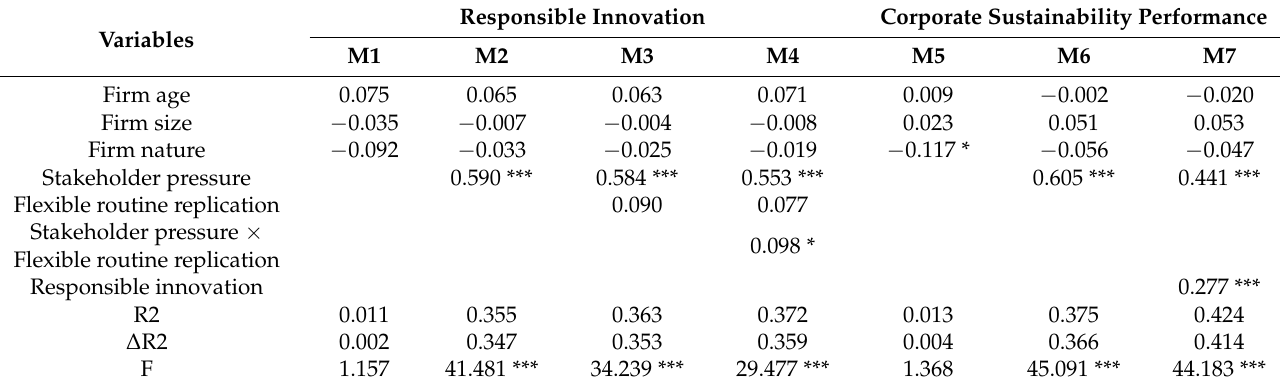
Table 3. Results of regression